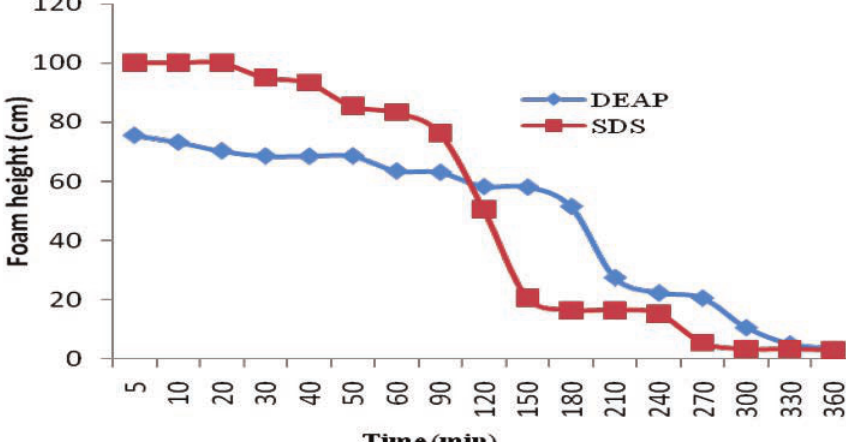
Figure 7. Comparism of the foam stability of sodium phosphate-hydroxy ethanolamide and SDS at 5 g/L as a function of time. DEAP = sodium phosphate-hydroxy ethanolamide.